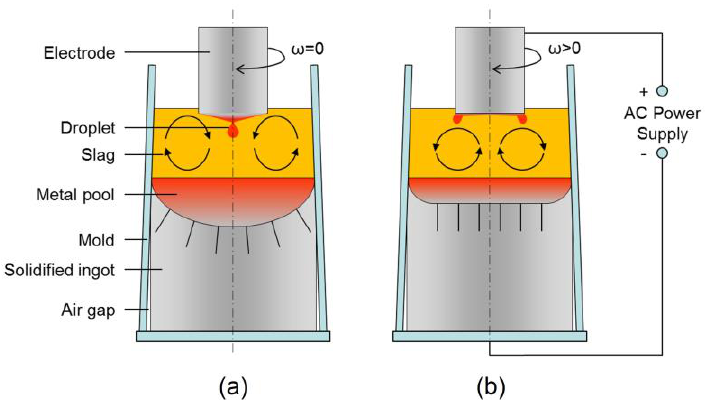
Figure 1. Process schematics of general ESR ( a ) and ESR with a rotating electrode ( b )